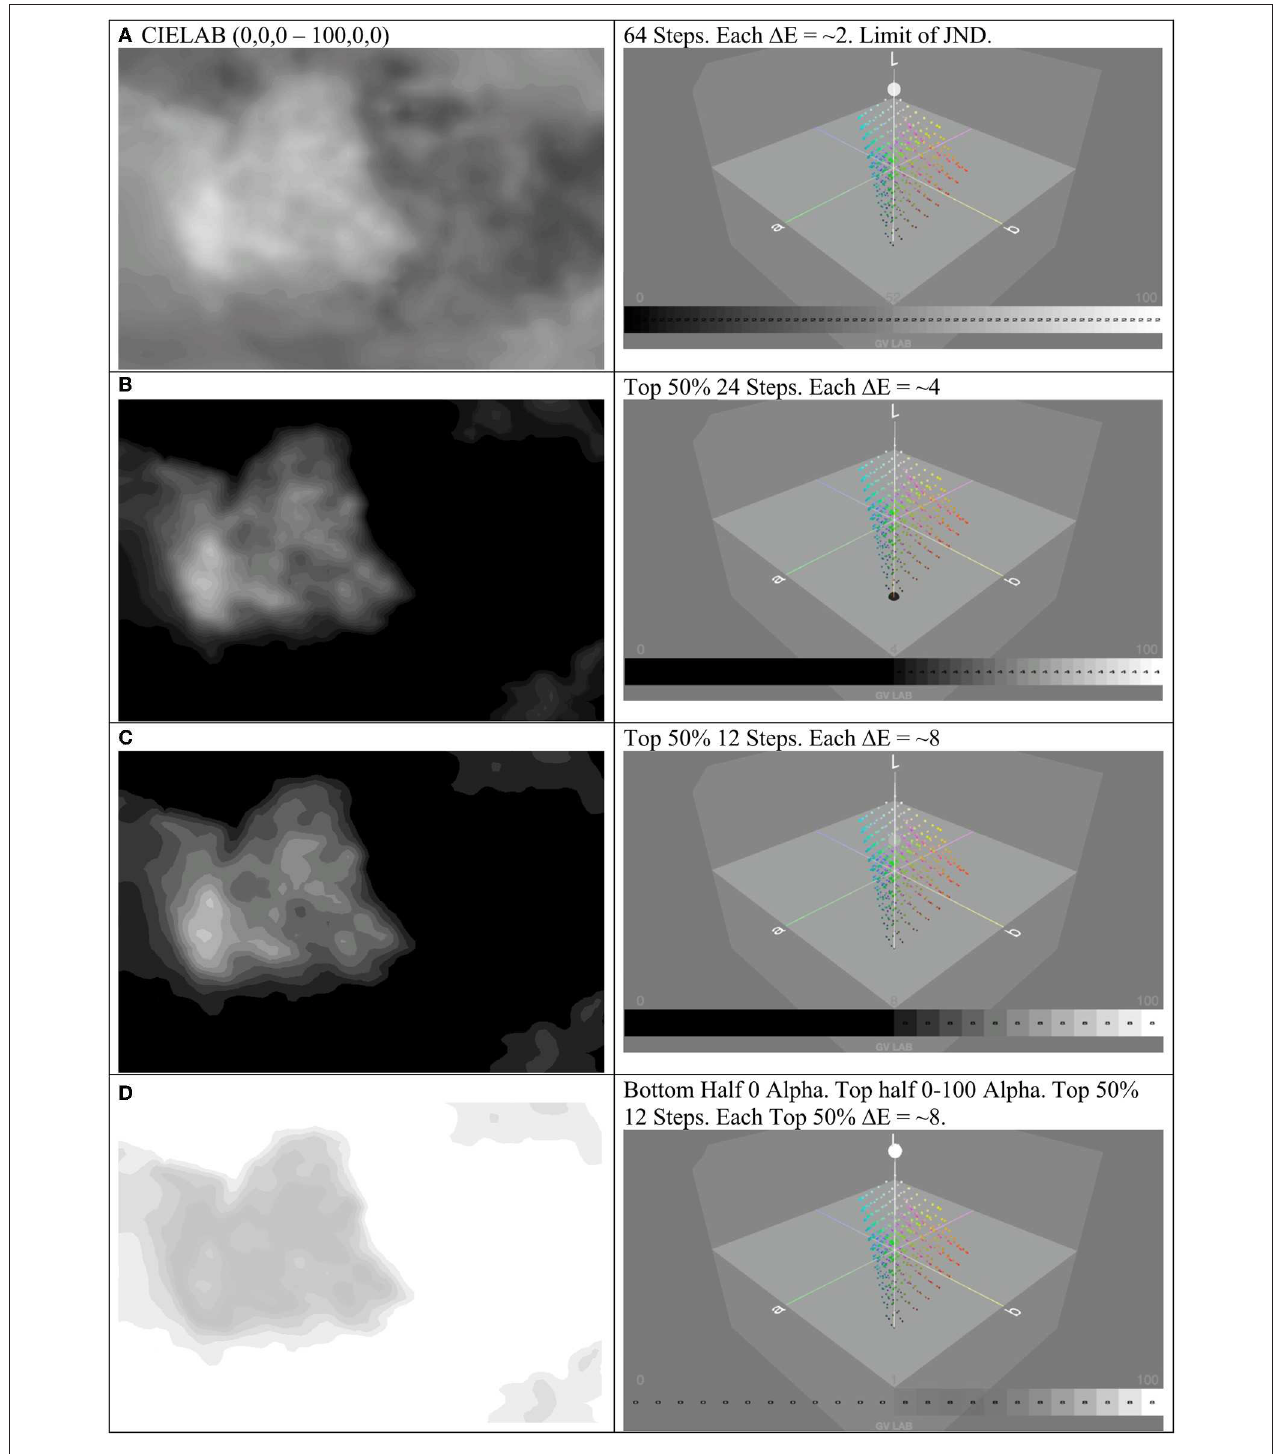
FIGURE 8 | Comparative visualizations, intended to highlight areas of detail, generated using the Gradient Designer App (left column) shown with supporting insights in CIELAB color space provided through the GV_LAB App (right column). For details of the grid values being displayed, see the caption for Figure 4 . (A) Detail All CIELAB 0-90L 64 Steps. (B) Detail top-half CIELAB 0-90L 24 steps. (C) Detail top-half CIELAB 0-90L 12 steps. (D) Detail top-half CIELAB 0-90L 12 steps + bottom-half alpha 0, top-half alpha 0-100. CIELAB colorspace conversions use D 65 2 ◦ illuminant. High resolution: https://doi.org/10.5281/zenodo.3264037.